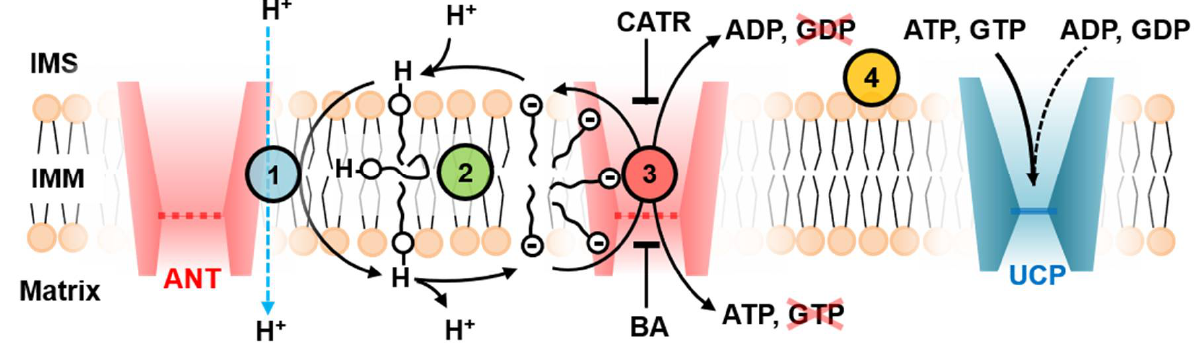
Figure 7. ANT1 transport features point to the fatty acid cycling mechanism. The proton transport rate of ANT1 (Table S3) in the presence of fatty acids (FA) is similar to that proposed for UCPs and depends on the FA structure (Circle 1, blue). ANT1 facilitates the FA anion’s transport at the protein-lipid interface, which is supported by the membrane conductance dependence on the FA structure (Circle 2, green). The FA anions slide alongside the electrostatic surface potential of ANT1; its modulation by binding ADP/ATP specific substrates inhibits the FA anion transport (Circle 3, red). The inhibition of ANT1-mediated proton leak is the strongest for the ANT1 substrates—ADP and ATP. It is in contrast to UCPs, in which the triphosphate nucleotides ATP and GTP are the most potent inhibitors (Circle 4, yellow).